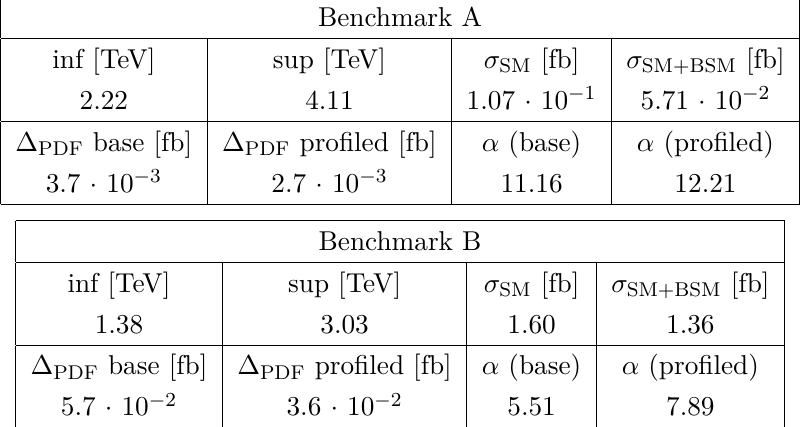
Table 5 . Integration limits for the dip region, integrated cross section for the SM background and the complete model and its PDF uncertainty with the baseline CT18NNLO PDF set [37] and the profiled PDF set using A FB + A W pseudodata as well as the significances α employing the two PDF errors for an integrated luminosity of 3000 fb − 1 for the benchmarks A and